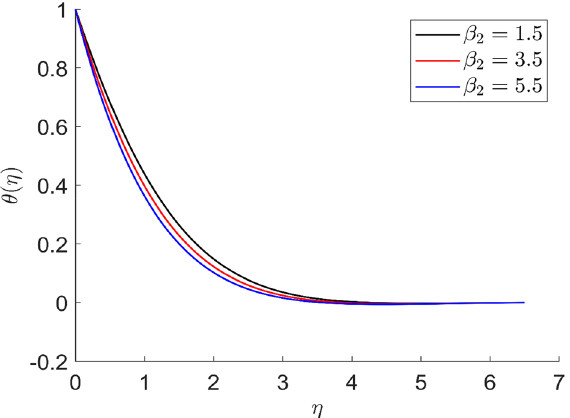
Figure 4. Representation of temperature θ(η) for the different values of β 2 (η) with R = 3, n = 3, v = 0.7, φ = 0.3, Pr = 0.6, φ 1 = 0.1, φ 2 = 0.8, m = 1.5, β = 0.4, β 1 = 0.5, β 3 = 0.5, u = 0.2, ξ = 0.2.